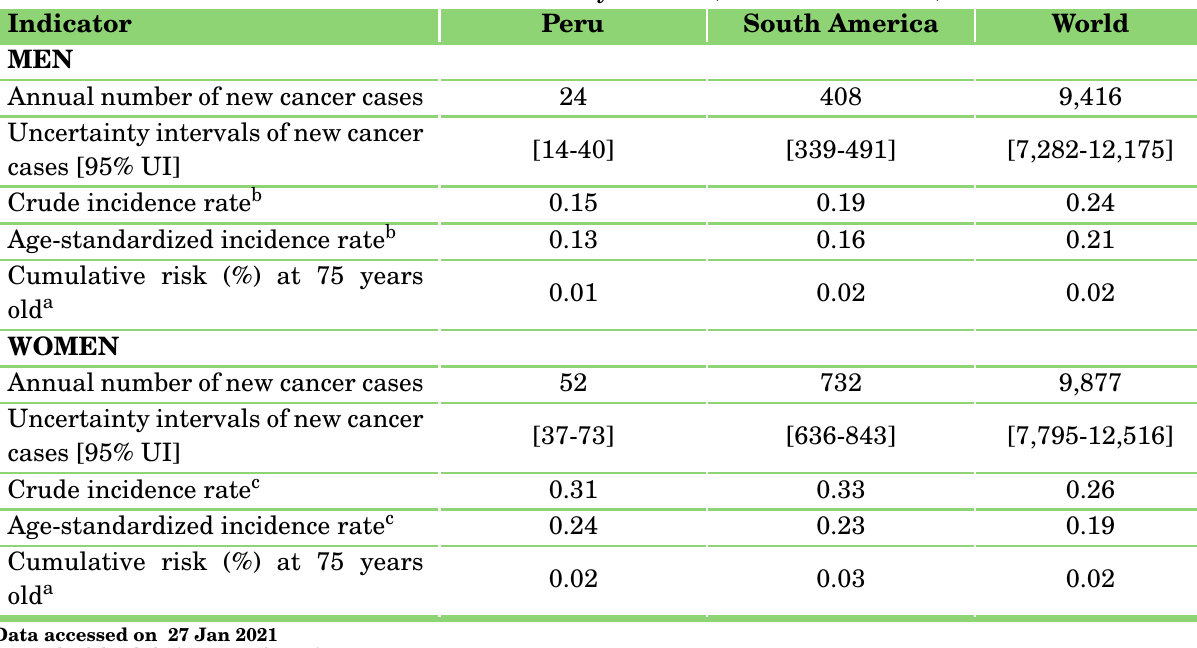
Table 8: Anal cancer mortality in Peru (estimates for 2020)